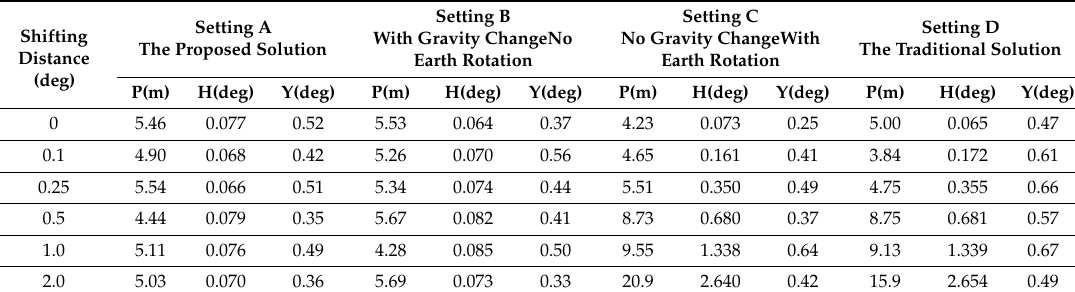
Table 2. The root-mean-square errors (RMSEs) of the position, horizontal attitude, and yaw of MTi-G-710 under different settings for the sequence at the test area of the Wuhan Research and Innovation Center (WRIC).